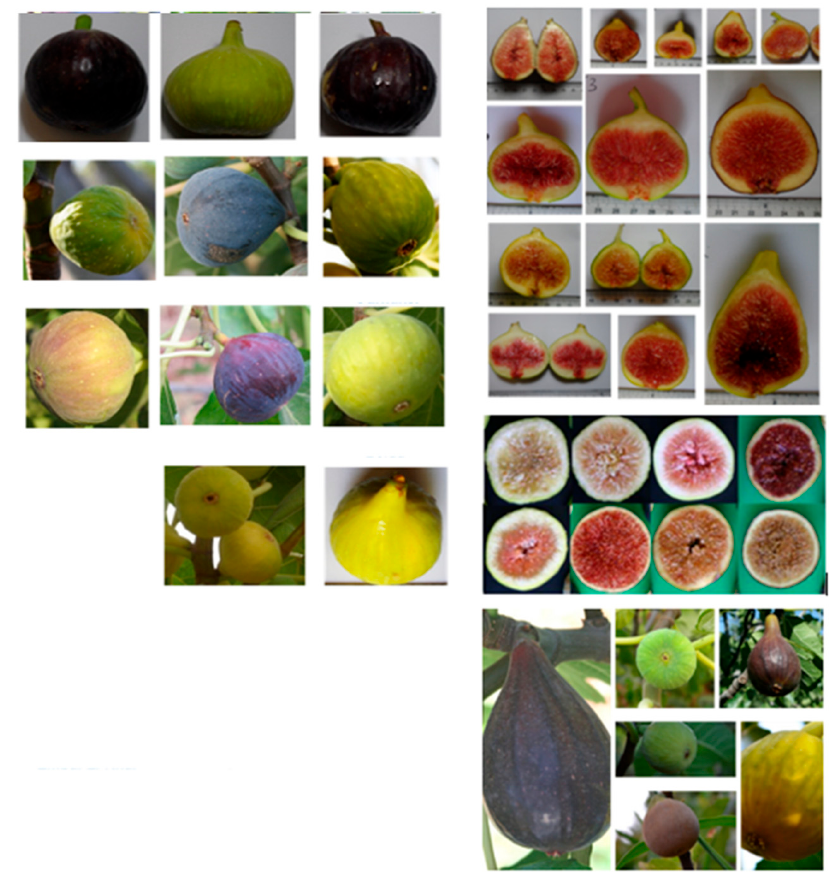
Figure 4. Image showing the diversity in fig chromatic coordinates for both peel and receptacle.